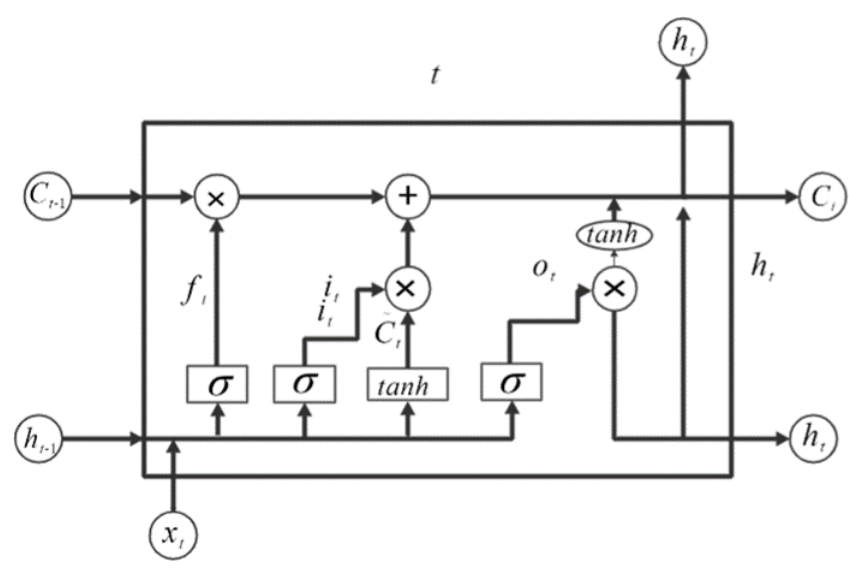
Figure 1. LSTM model diagram.